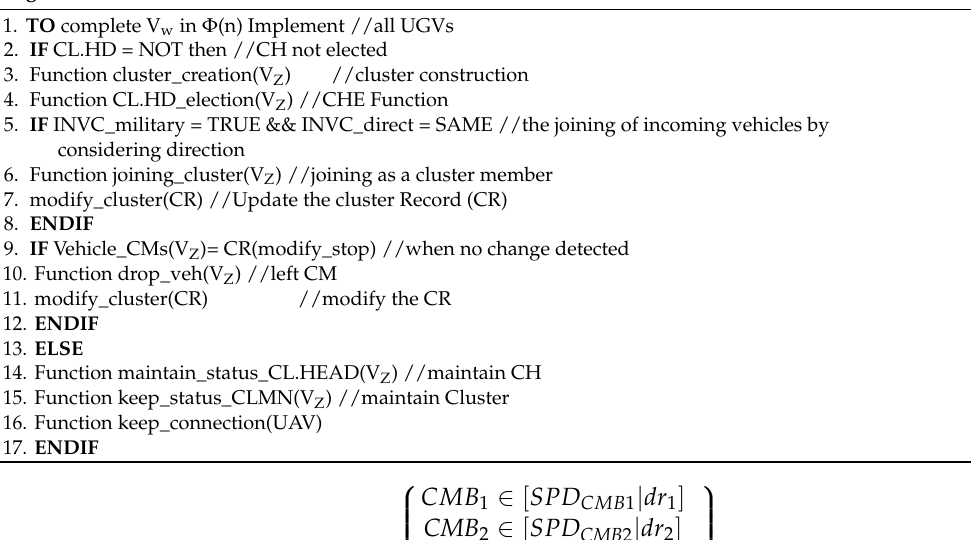
Algorithm 1 . Creation and maintenance functions for